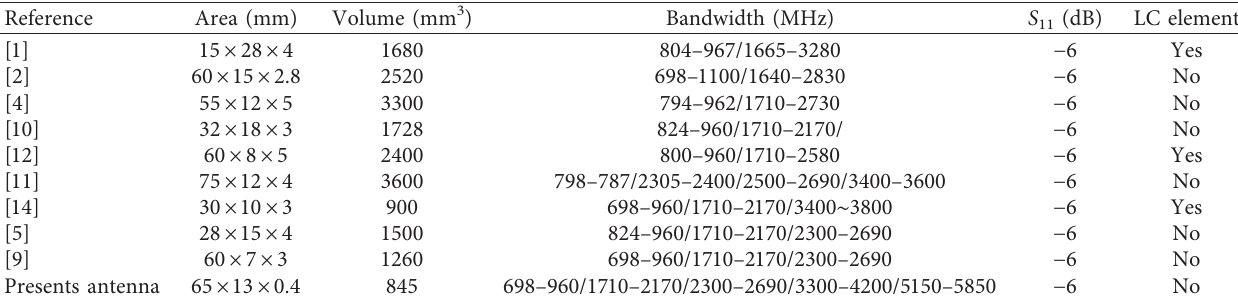
Table 3: Comparison between the present antenna and reference